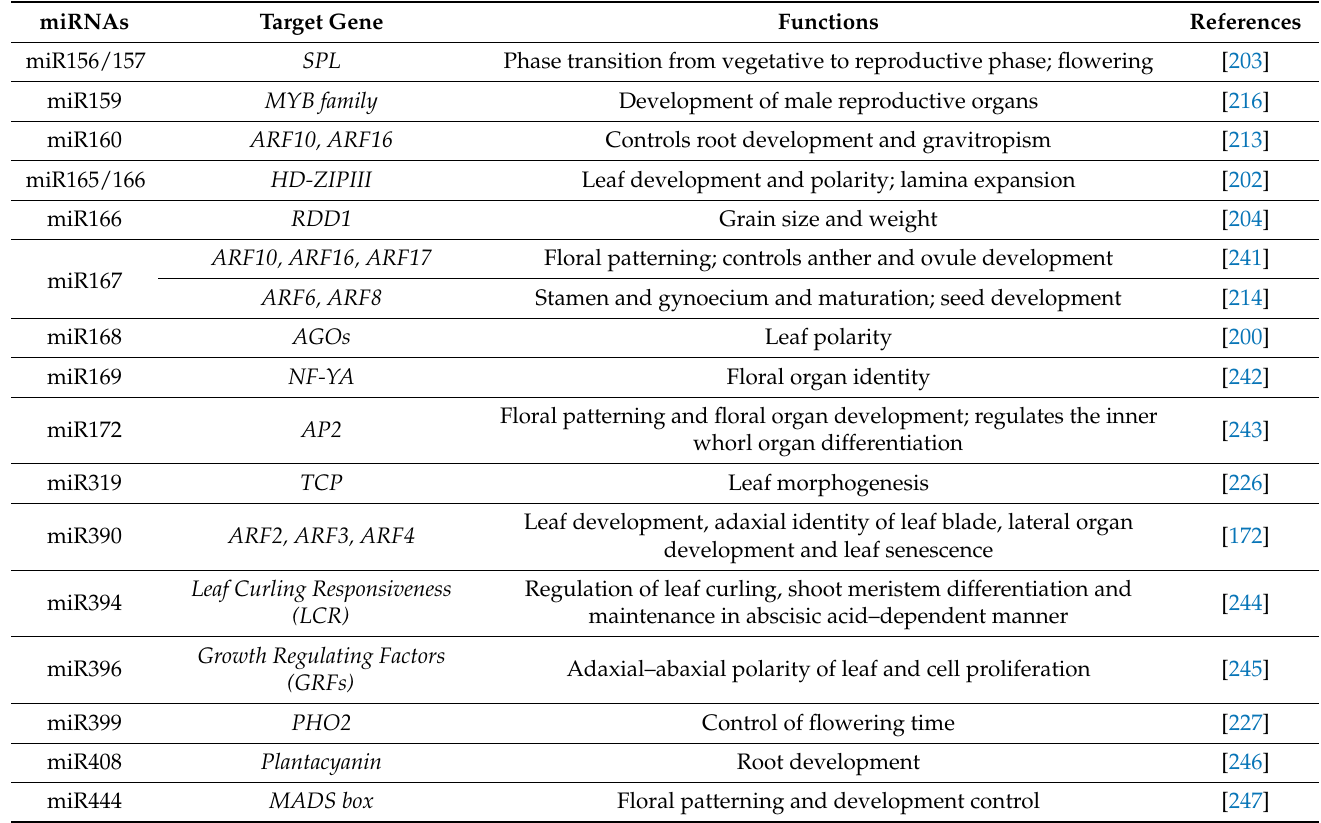
Table 2. List of conserved miRNAs and their key target genes that function in plant growth and development. miRNAs Target